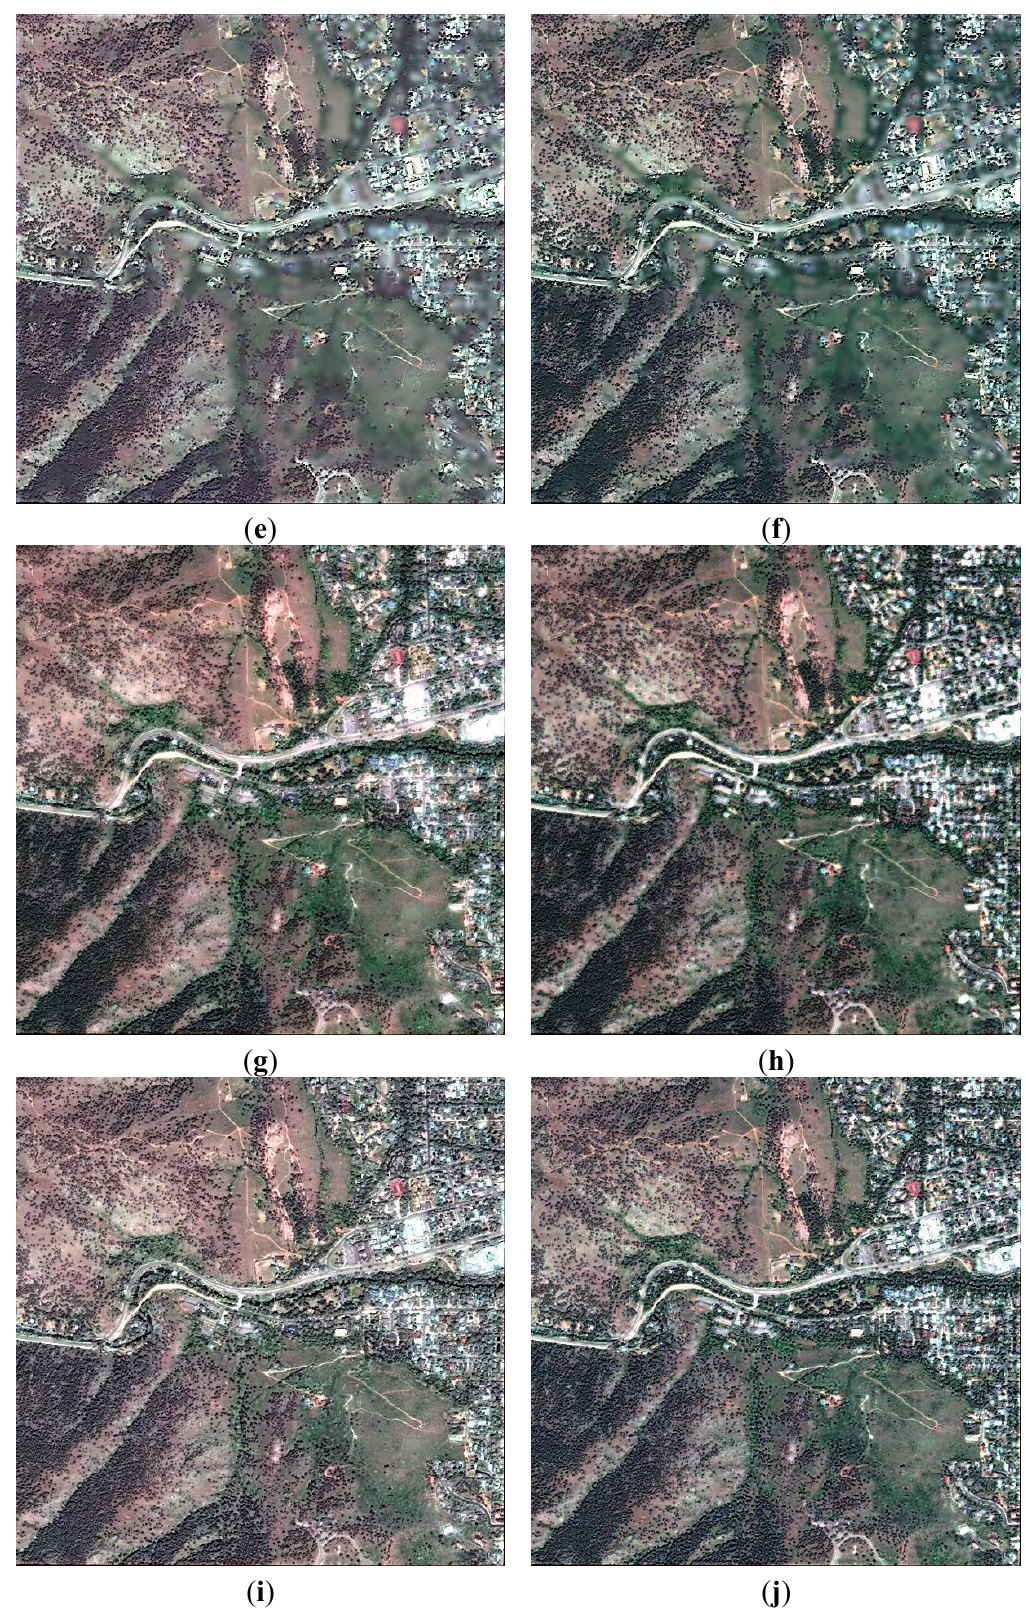
Figure 3 . True color display of the fused results from different strategies for the QuickBird dataset at the reduced scale. ( a ): Observed at a 2.4-m spatial resolution; ( b ): EXP; ( c ): GS; ( d ): GS-spectrally consistent; ( e ): GLP-ECB; ( f ): GLP-ECB-spectrally consistent; ( g ): GLP-M3; ( h ): GLP-M3-spectrally consistent; ( i ): GLP with s = 0.75; ( j ): Spectrally consistent GLP with s =